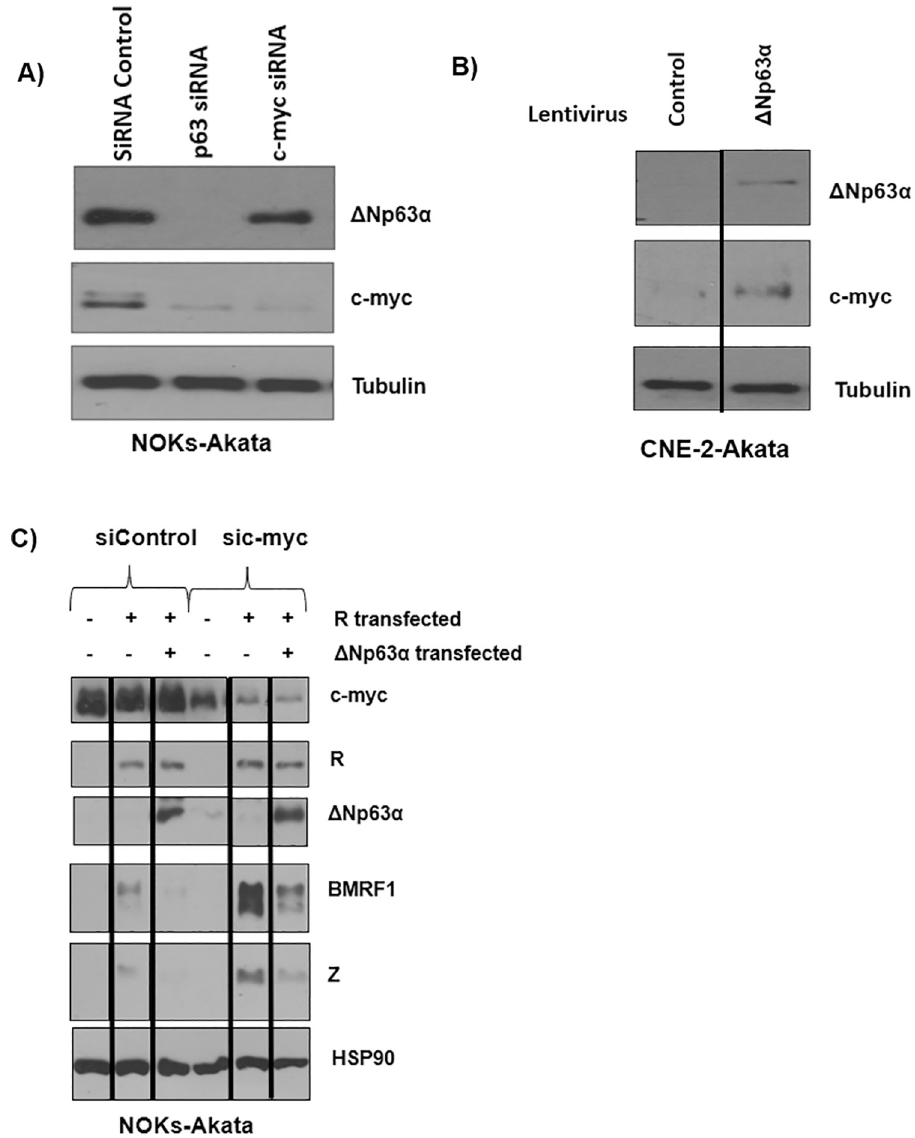
Fig 10. Δ Np63 α expression increases the expression of the lytic repressor c-myc, but c-myc is not required for Δ Np63 α mediated repression of lytic reactivation. A) NOKs-Akata cells were transfected with either Δ Np63 α or c- myc targeting siRNAs or a control nonspecific siRNA. Two days after siRNA transfection, the cells were harvested for an immunoblot to determine the expression levels of Δ Np63 α , c-myc, and tubulin (as a loading control). B) CNE- 2-Akata cells were infected with a Δ Np63 α expressing lentivirus or empty control. After five days of puromycin selection, the cells were harvested and an immunoblot performed to assess expression of the Δ Np63 α , c-myc and tubulin proteins. C) NOKs-Akata cells were transfected with siRNAs against c-myc or a control siRNA for two days, and then transfected with or without an R expression vector in the presence or absence of Δ Np63 α . Immunoblot was performed one day later to examine expression of c-myc, Δ Np63 α , R, BMRF1, Z, and tubulin proteins. Black lines indicate where irrelevant lanes in the blot were removed; the original western blots used to construct this figure are shown in supplemental Fig 8. All experiments are representative of two independent experiments. inhibition of p38 kinase activity decreased expression of its known downstream target, TTP (ZFP36)[87]. Specific knock-down of MAPK14 (p38 α ) expression inhibited R’s ability to acti- vate BMRF1 expression while having a lesser effect on BZLF1 expression (Fig 11E ).